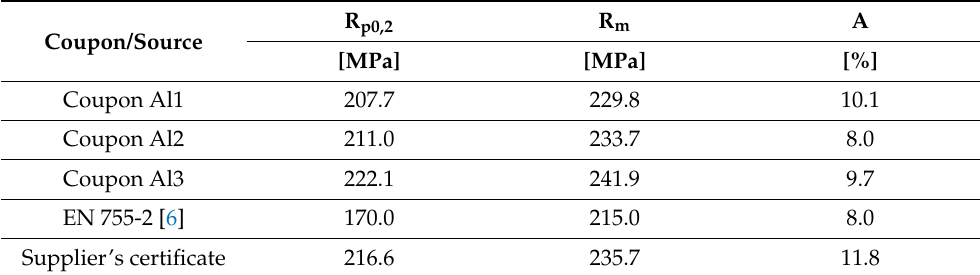
Table 1. Comparison of mechanical